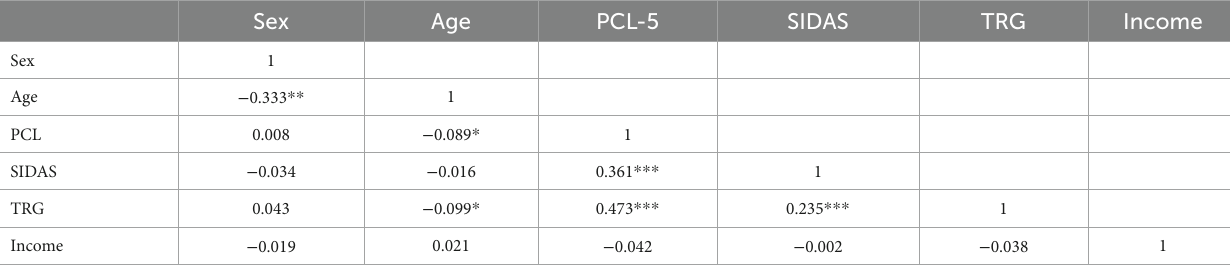
TABLE 2 Results of Pearson’s correlation analyses among